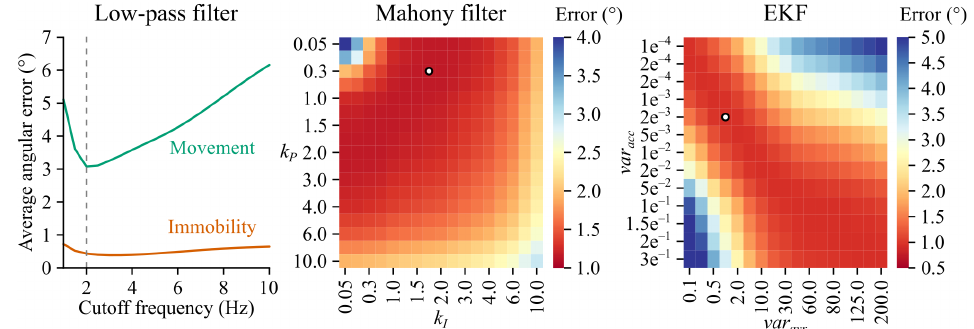
Figure A4. Parameter optimization for the low-pass, Mahony and extended Kalman filters. Optimal parameters were the ones minimizing the average tilt estimation error on all recorded data (36min). For the low-pass filter (left panel), the optimal cutoff frequency was 2Hz during movement and lay in the 2–4Hz during immobility. A grid search algorithm was used to find the optimal pair of parameters for the Mahony and extended Kalman filters (middle and right panels; the optimal combination of parameters is highlighted by a white circle).